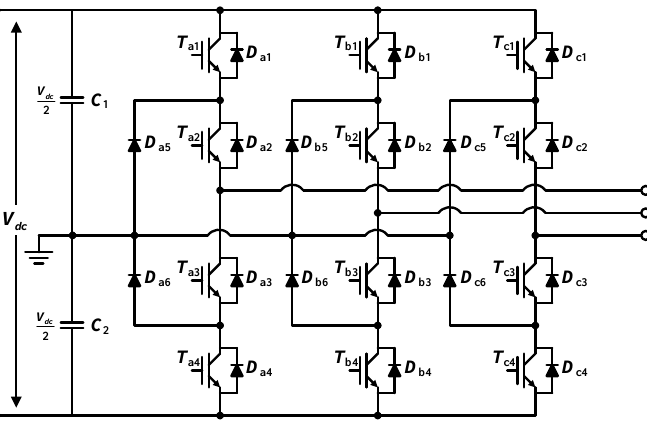
Figure 1. Configuration of the three-level neutral point clamped (NPC) voltage source inverter (VSI).